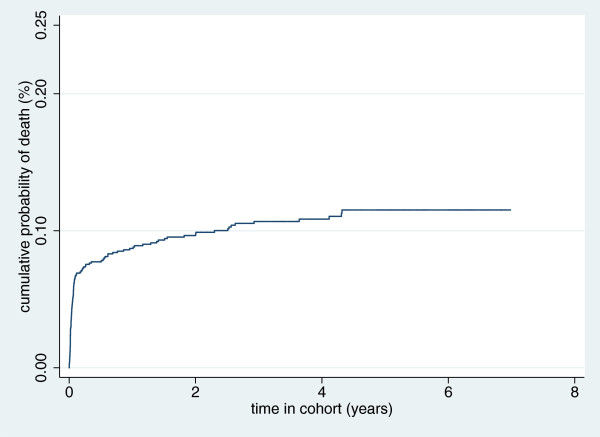
Kaplan-Meier curve of cumulative probability of death.